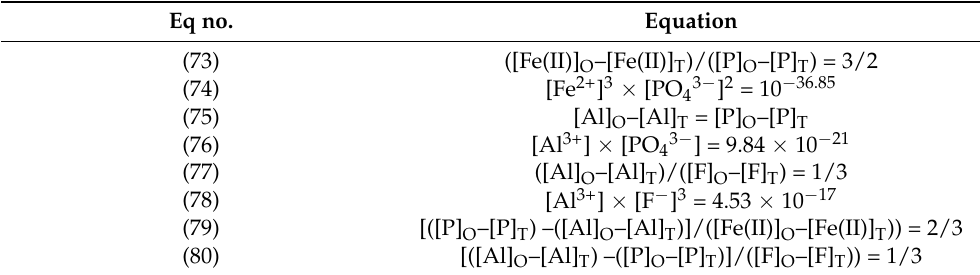
Table 5. Constraint equations for different solid phase stable region.